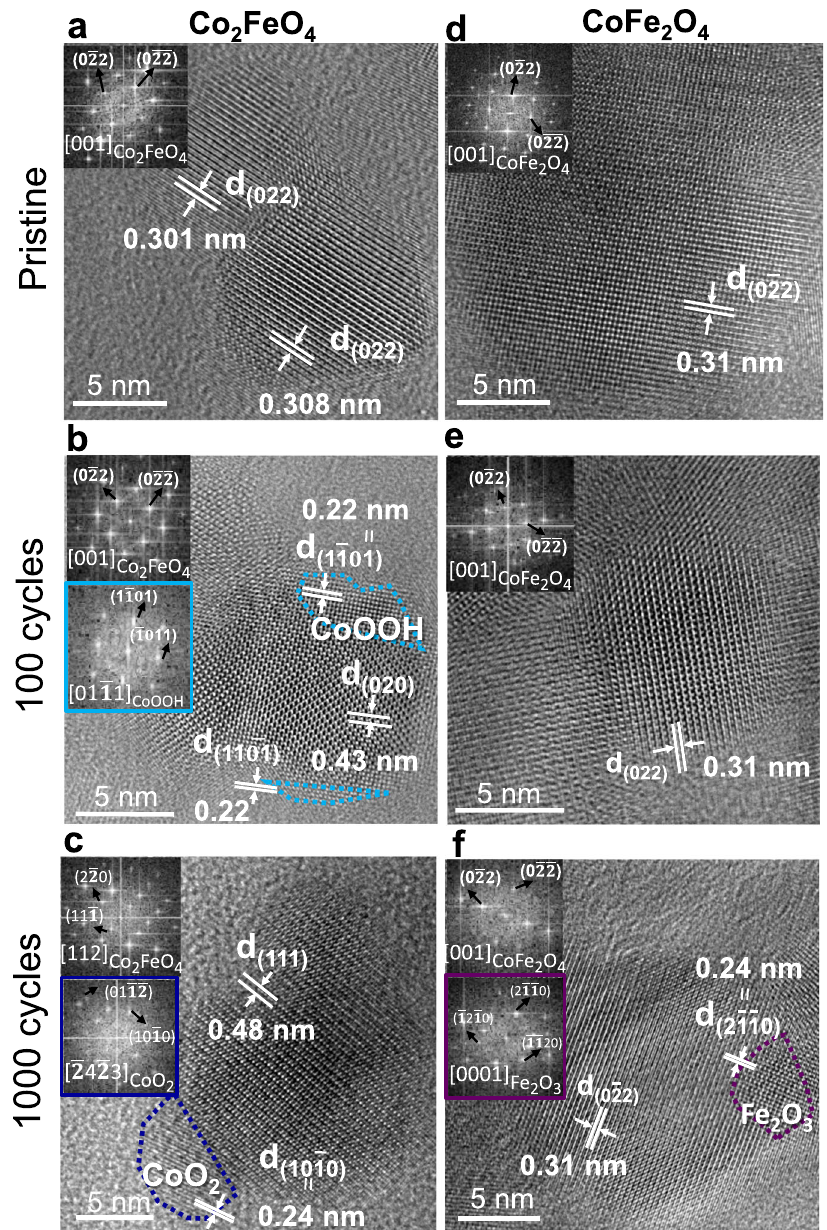
Fig. 3 Surface structural evolution of Co 2 FeO 4 and CoFe 2 O 4 during OER. High-resolution TEM images of Co 2 FeO 4 and CoFe 2 O 4 a , d in the pristine state, b , e after 100 cycles and c, f after 1000 cycles. The top insets in a – f were Fourier fi ltered transform images obtained from the centre of nanoparticles, and the bottom insets in b , c , f were recorded from the surface regions of nanoparticles highlighted by the dashed lines, indicating the occurrence of phase transformation on the surface regions of Co 2 FeO 4 and CoFe 2 O 4 during